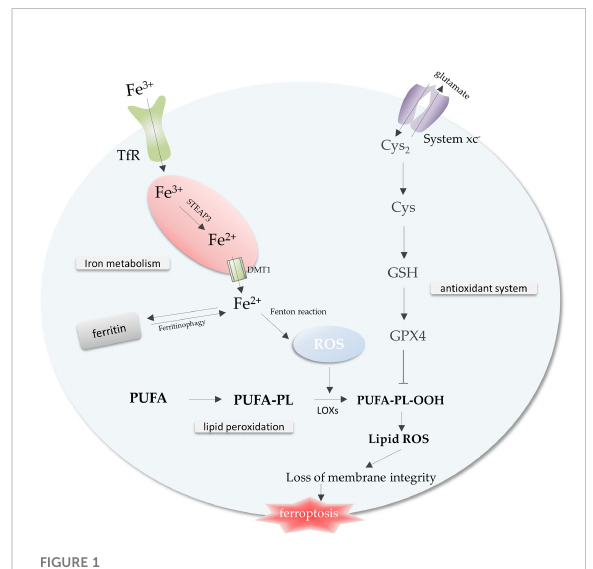
FIGURE 1 The core mechanisms related to ferroptosis. Free iron promotes intracellular ROS accumulation through the Fenton reaction, leading to lipid peroxidation and ferroptosis. The antioxidant system inhibits the lipid peroxidation process to prevent ferroptosis. Imbalance of iron metabolism, lipid peroxidation and antioxidant system leads to the occurrence of ferroptosis. Abbreviations: TfR, transferrin receptor; ROS, reactive oxygen species; Cys2, cystine; Cys, Cysteine; GSH, glutathione; GPX4, glutathione peroxidase 4; PUFA-PL, polyunsaturated fatty acid- containing